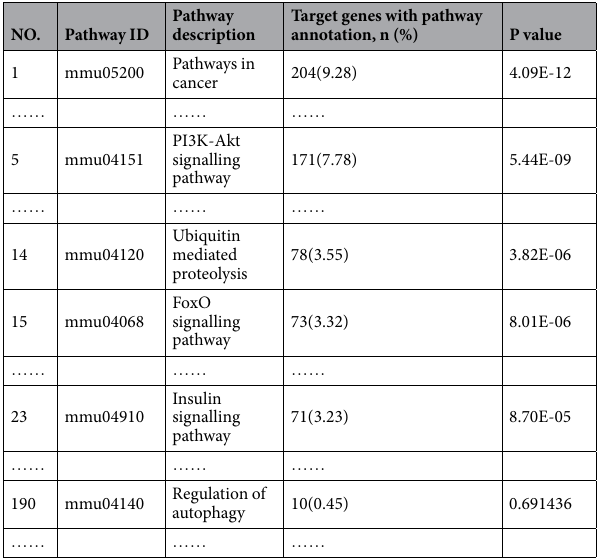
Table 2. KEGG pathways enriched by target genes of differentially expressed miRNAs. P < 0.05 with significant